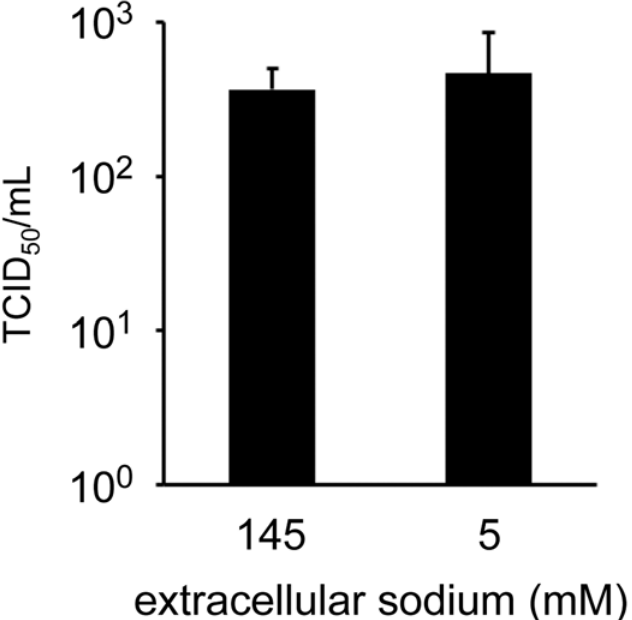
Fig 5. HDV infection in the absence of a sodium gradient. HuH-7/hNTCP cells were exposed to HDV contained in a solution with regular (145 mM Na + ) or low (5 mM Na + ) sodium for 6 hours. Then cells were washed and wells were repleted with regular media. TCID 50 assay was performed on day 5 after infection. Each data point represents the mean +/- SD of n = 4 individual TCID 50 assays (48 wells each) performed on separate